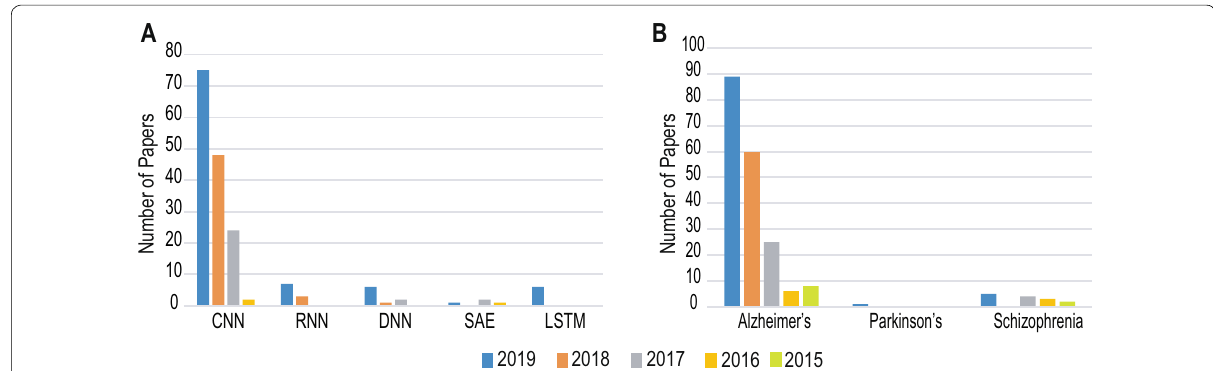
Fig. 1 Peer-reviewed research results published during the last 5 years reporting the usage of DL in detecting NLD from MRI data. The Scopus database (https ://www.scopu s.com/) was searched with search-strings containing keywords “Deep learning” and “MRI” in conjunction with each of the NLD (“Alzheimer’s”, “Parkinson’s”, and “schizophrenia”) and the obtained results were categorized basing on the DL architectures ( a ) and diseases ( b ). A. In the literature the CNN has been reported much more frequently in comparison to the RNN, LSTM, DNN, and AE. B. The main effort appears to cluster around AD in comparison to PD and